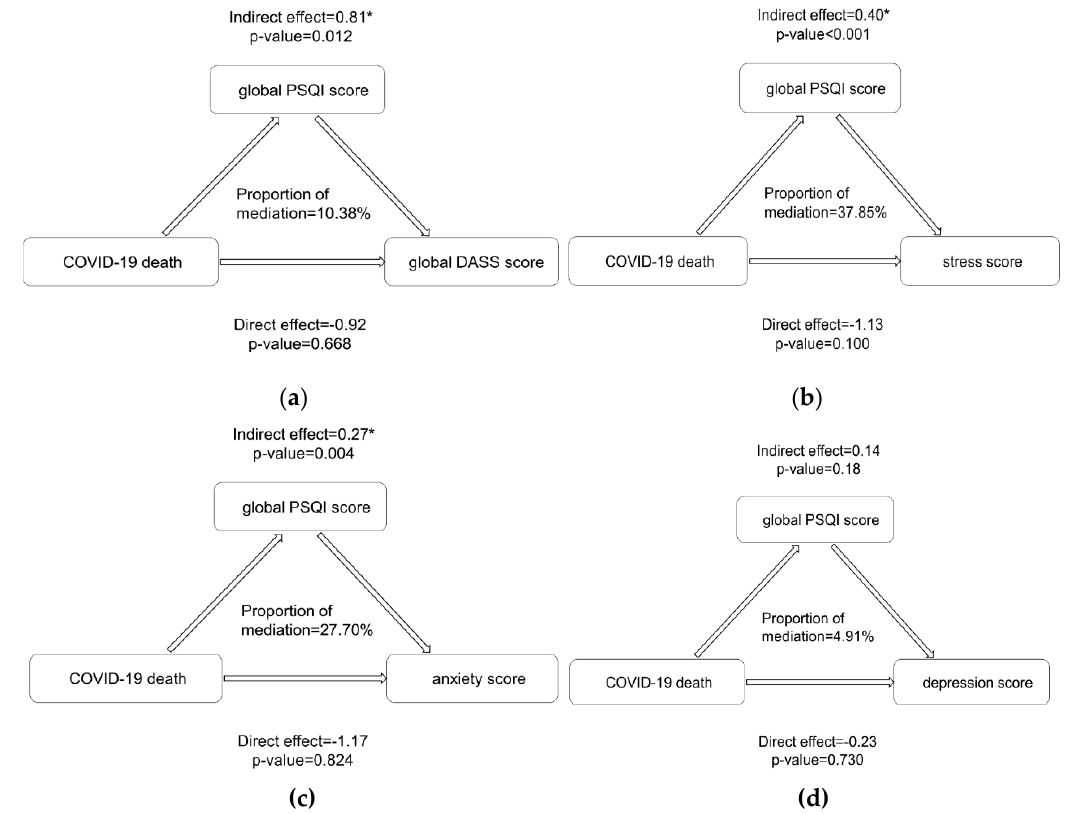
Figure 2. Mediation e ff ects of sleep quality on the relationship between COVID-19 deaths and negative emotions. Note: The subgraph of ( a – d ) indicates the indirect influencing path of the COVID-19 on global negative emotions, stress, anxiety and depression, respectively, with sleep quality playing as a mediator. In Figure ( a ), indirect e ff ect = 0.81 means that for every 1000 increase in the COVID-19 death count, there is an indirect e ff ect on the global DASS score and an associated increase in the global DASS score of 0.81, indicating an increased level of negative emotions. The same interpretation also holds for other figures. Asterisks indicate significance at the 5% level. MET: the ratio of work metabolic rate to a standard resting metabolic rate. METs: energy expenditure in MET-minutes per week; PSQI: Pittsburgh Sleep Quality Index. Calculation of mediation e ff ects and proportion of mediation was completed in the mediation package of R software, version 3.6.3.